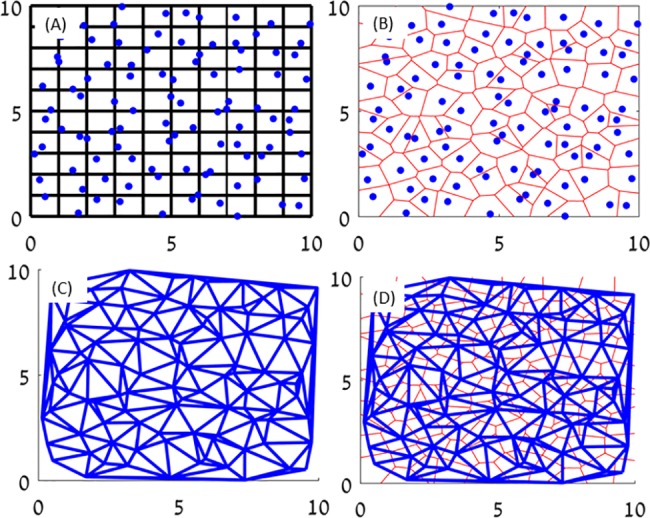
The stages of creating the VRL.(a) A uniform reference lattice with a single node chosen uniformly in each cell. (b) The Voronoi diagram for the random nodes. (c) The Delaunay triangulation yields (d), the final VRL.